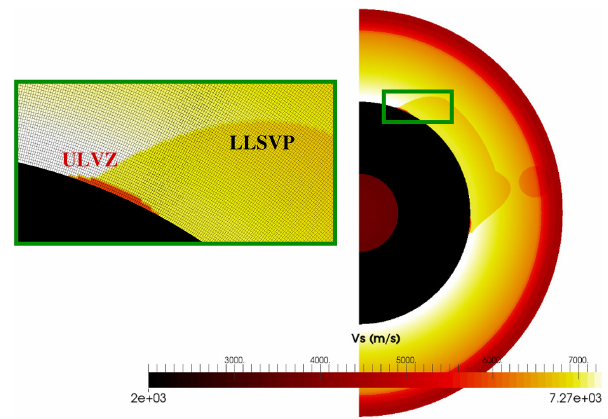
Figure 9. Two examples of random wavespeed variations superim- posed onto PREM. Left: Variations with depth only. Middle: Varia- tions in 2.5-D. Right (top): Zoom into the crust for the 2.5-D random medium. Right (bottom): Radial profile of these two realizations with respect to PREM.